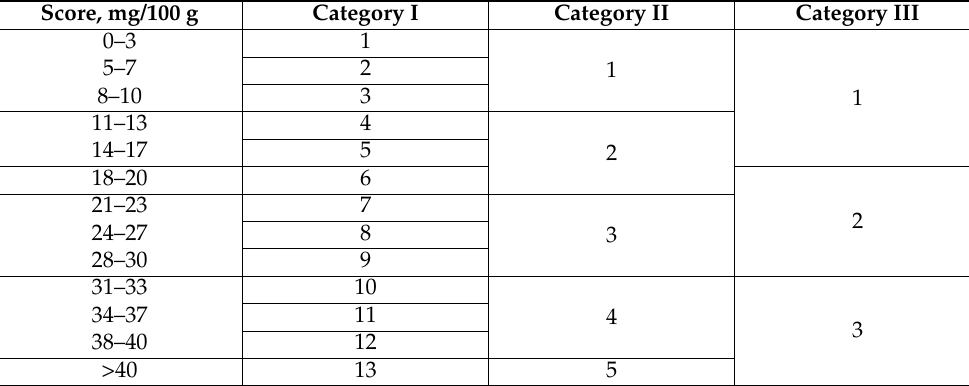
Table 4. Category range